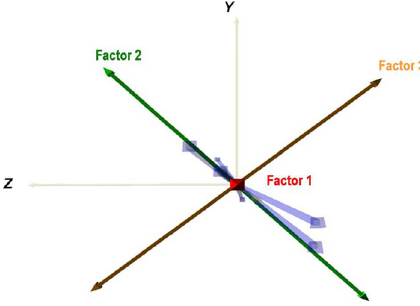
FIG. 6. (cid:1) Color (cid:2) Three factors are more aligned with the blue vectors than the x , y , and z axes. Here, the x axis is too close to factor 1 and therefore is not labeled in the